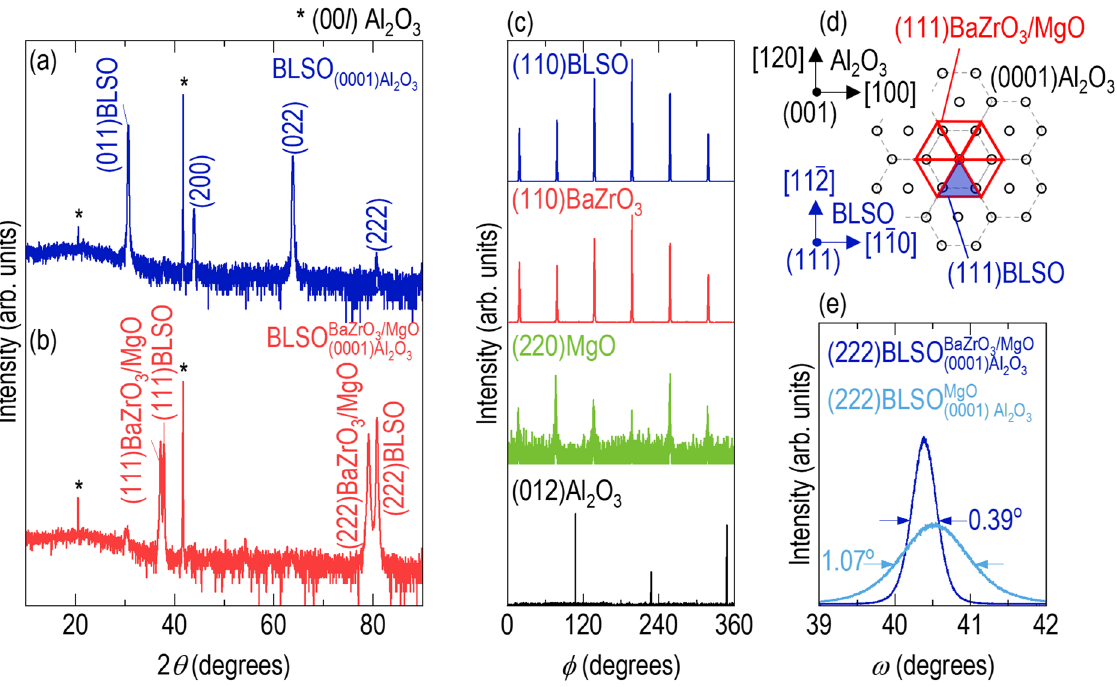
Fig. 1 Epitaxial stabilization of BLSO films on (0001)Al 2 O 3 with BaZrO 3 /MgO template bilayer. For convenience, the simpler form of BLSO template layers substrate is used. a The (110), (200), (220), and (222) diffraction peaks in the X-ray diffraction (XRD) θ–2θ scan of BLSO ( 0001 ) Al indicate the formation of 2 O 3 mixed-crystalline phases. The asterisks indicate the (003) and (006) diffraction peaks of Al 2 O 3 . b The XRD θ–2θ scan of BLSO BaZrO 3 / MgO ( 0001 ) Al shows the 2 O 3 (111) and (222) diffraction peaks of BaZrO 3 /MgO and BLSO, indicating the formation of (111)-oriented BLSO epitaxial films on (0001)Al 2 O 3 with (111) BaZrO 3 /MgO template bilayer. c The XRD φ scans of (110)BLSO, (110)BaZrO 3 , and (220)MgO show six diffraction peaks separated by 30° from (012) Al 2 O 3 , corresponding to three-fold symmetric in-plane matching, as schematically shown in d . e The full-width at half-maximum in the XRD ω -scans decrease from 1.07° in BLSO MgO ( 0001 ) Al to 0.39° in BLSO BaZrO 3 / MgO ( 0001 ) Al , indicating an improved crystallinity of the BLSO epitaxial films with the use of the 2 O 3 2 O 3 BaZrO 3 template